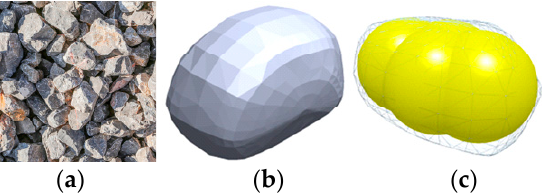
Figure 5. Establishment of particle models: ( a ) The limestone particles; ( b ) 3D model of the limestone particles; ( c ) The material particle in EDEM.